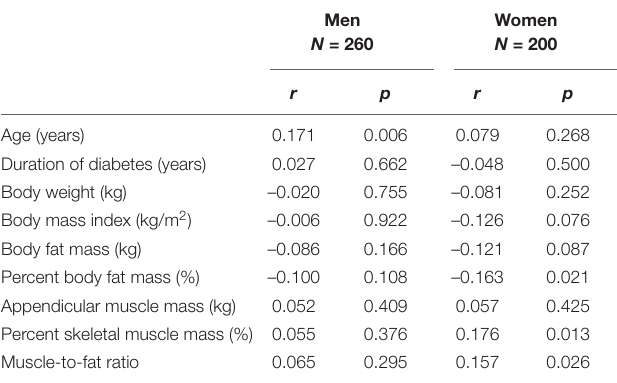
TABLE 3 | Correlation between dietary fiber intake and clinical